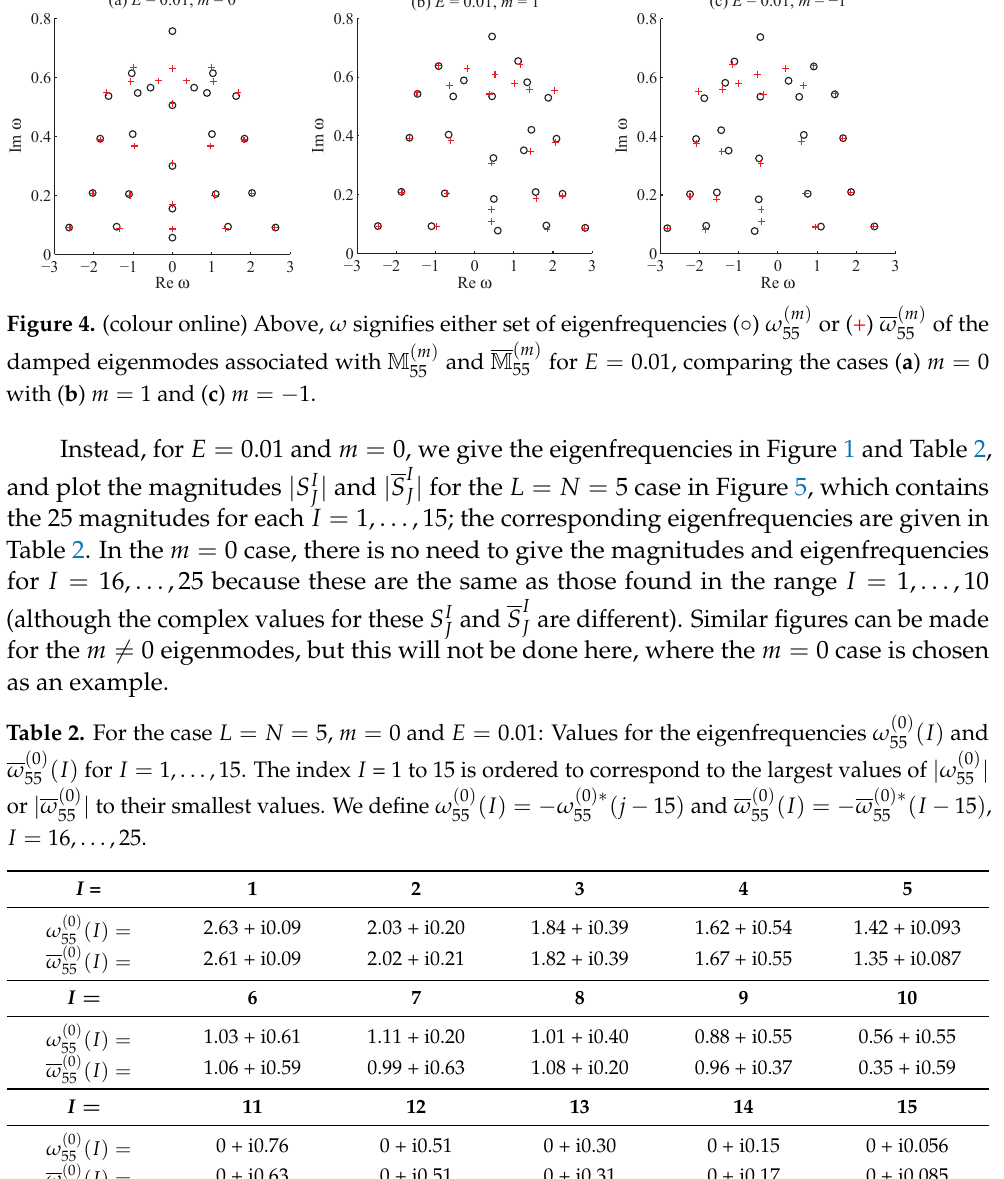
( I ) = − ω ( 0 ) ∗ ( j − 15 ) and ω ( 0 ) 55 55